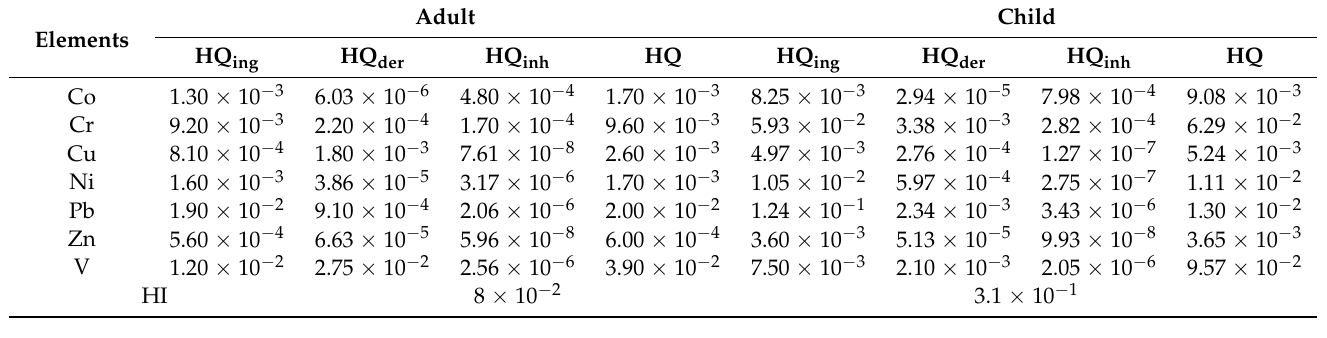
Table 3. Non-carcinogenic risk index of potentially toxic elements in adults and children. Table 3. Non ‐ carcinogenic risk index of potentially toxic elements in adults and children.